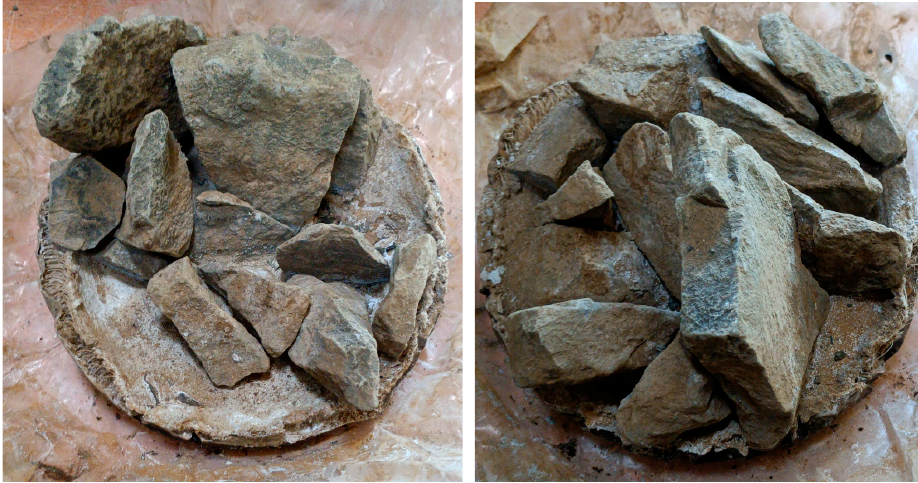
Figure 8. The ballast particles bonded in the CC layer. These stones could not be removed by hand. The thickness measurements of the CC based on the CT reconstruction revealed dif- fering amounts of thinning. Figure 9 shows a typical thickness profile of the CC. The thick- ness profiles were obtained by determining the CC’s top and bottom surfaces and execut- ing the thickness analysis provided by the analysis software. The thickness analysis is performed by projecting lines from one surface to the opposing surface and measuring the length of the projected line segment. These lengths correspond to the thickness of the two surfaces. The thickness is presented using a colormap overlaid on the CC. Warmer colors (red and yellow) correspond to thick regions close to the original thickness of the CC. In contrast, colder colors (cyan and blue) represent thin regions.